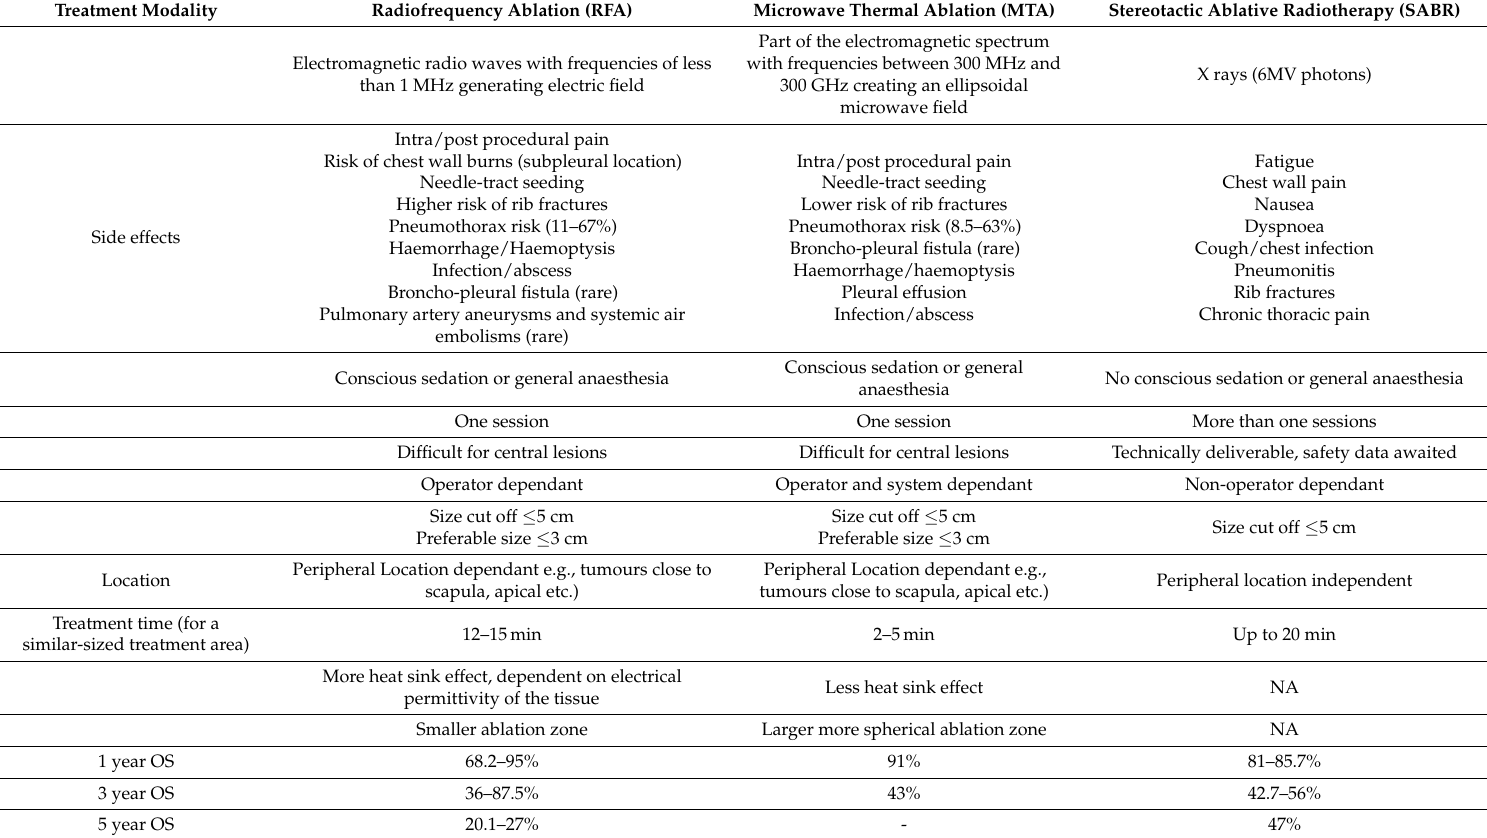
Table 1. Comparison of different treatment modalities with pros and cons.